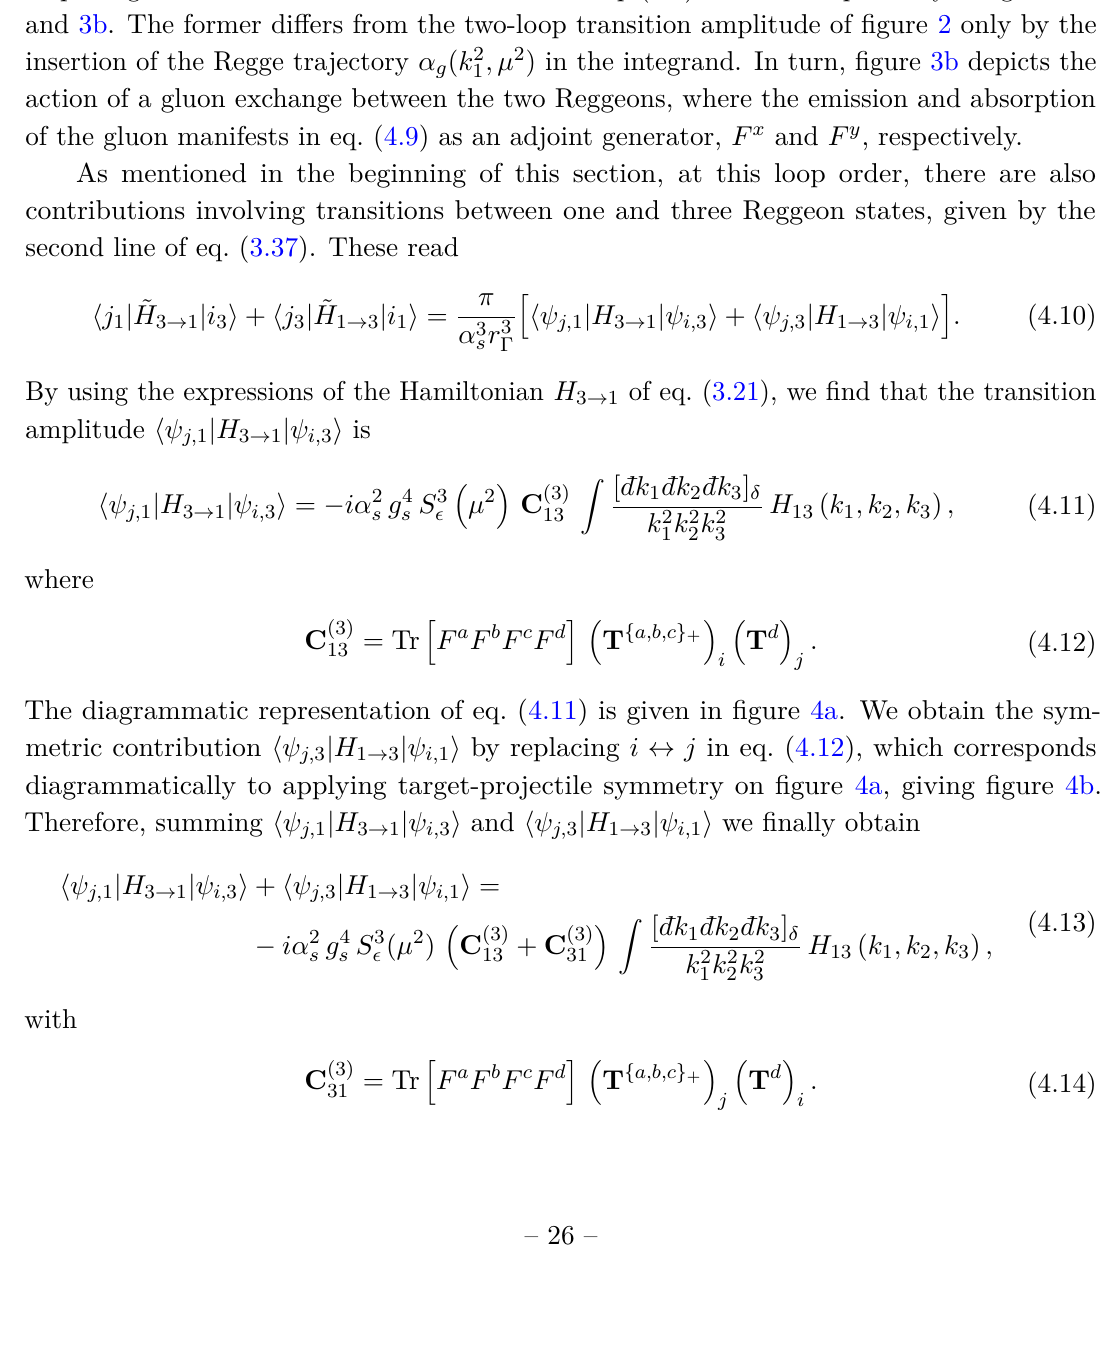
A diagrammatic representation of both the colour structure and the momentum flow of the loop integrals of each of the two contributions in eq. (4.8) is shown respectively in figures 3a and 3b. The former differs from the two-loop transition amplitude of figure 2 only by the insertion of the Regge trajectory α ( k 2 , µ 2 ) in the integrand. In turn, figure 3b depicts g 1